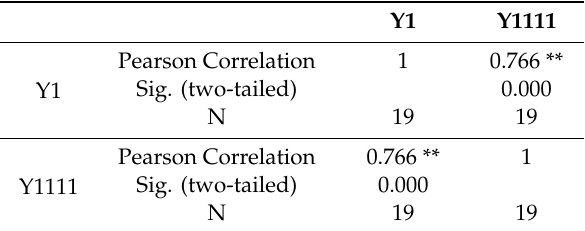
Table 6. Correlations between Y1 and